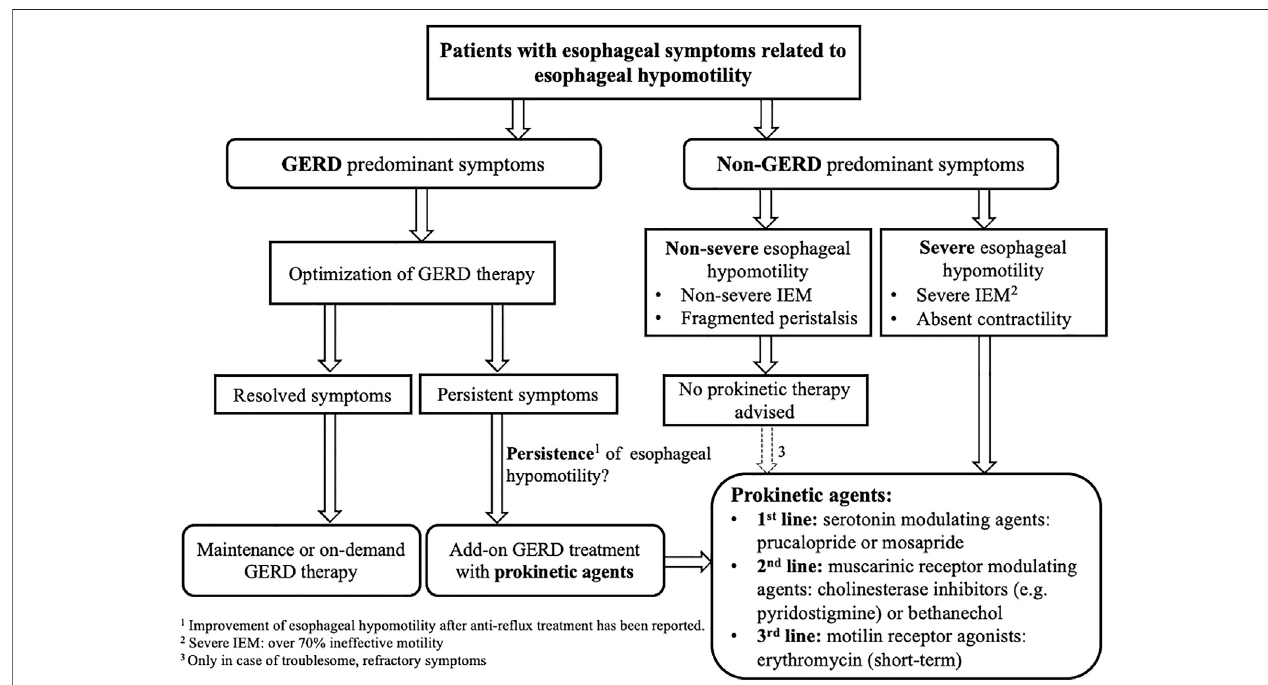
FIGURE4| GuidedalgorithmillustratingprokineticdrugsapplicationinsettingofesophagealhypomotilityGERD,Gastroesophagealre fl uxdisease;IEM,Ineffective esophageal motility; 5-HT, 5-Hydroxytrptamine.